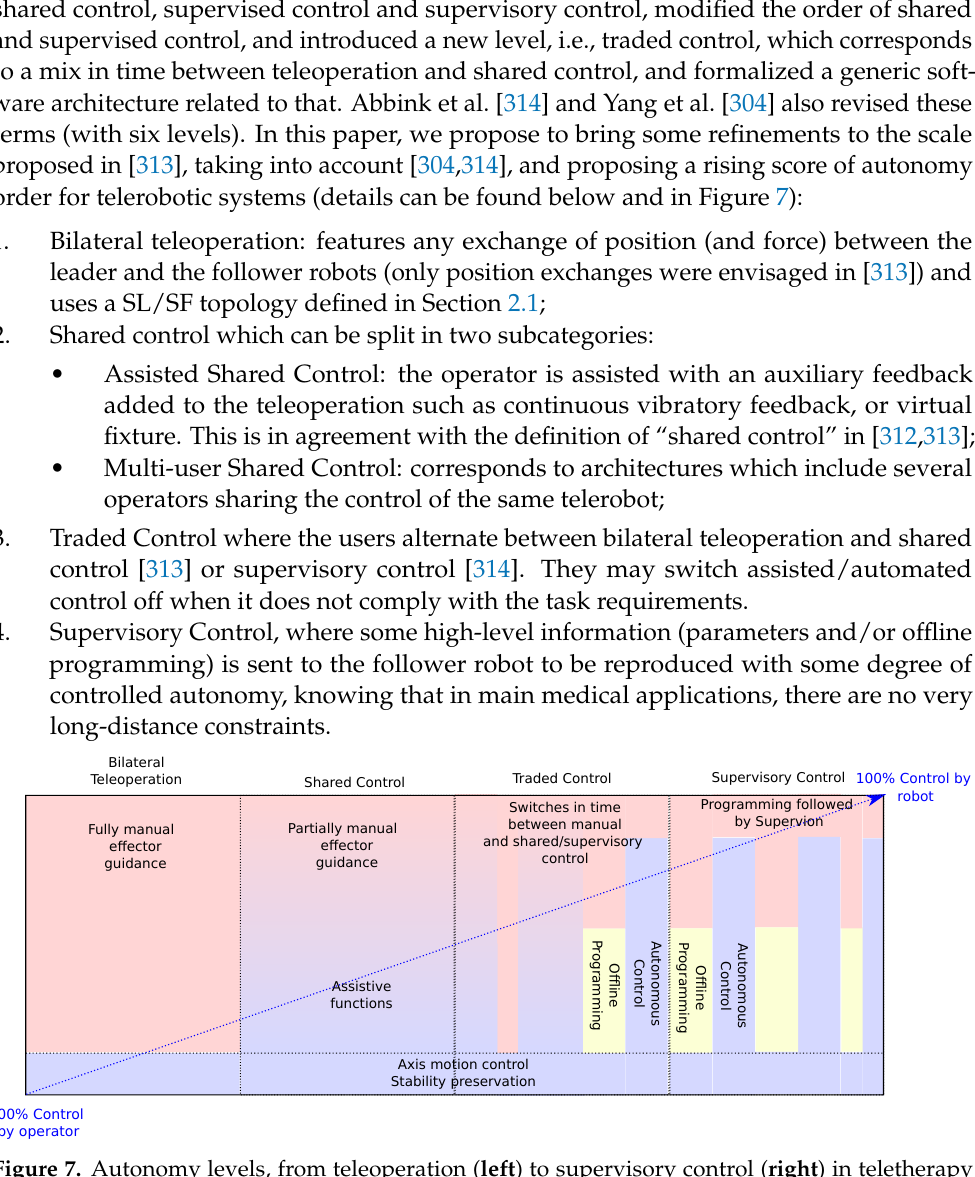
Figure 7. Autonomy levels, from teleoperation ( left ) to supervisory control ( right ) in teletherapy